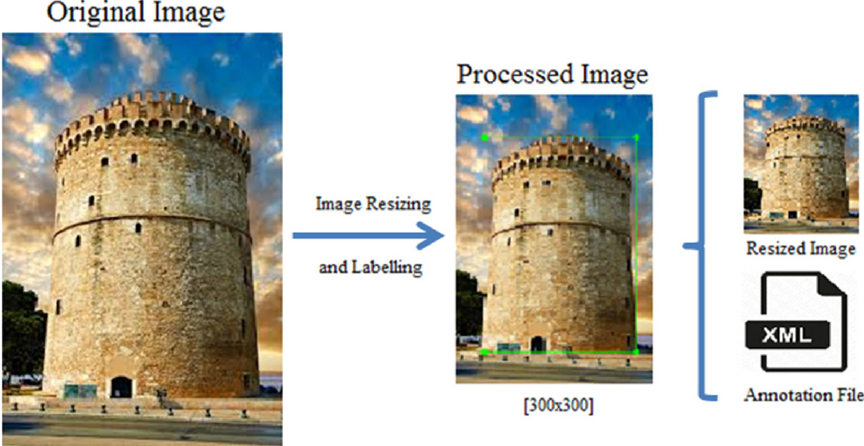
Fig. 2. Data pre-processing